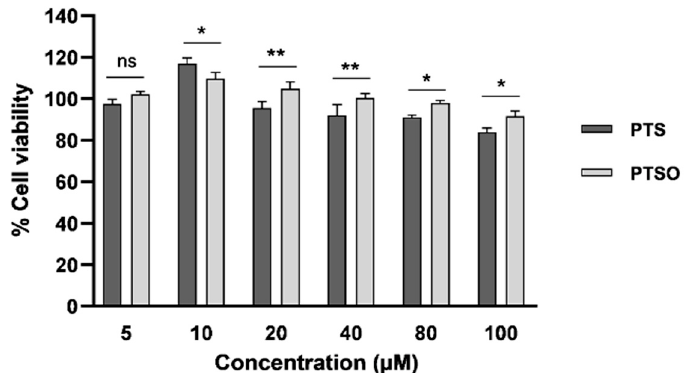
Figure 2. Effects of increasing concentrations of PTS and PTSO on hMSCs viability three days post-induction. The histogram depicts means ± SD of six determinations. * p < 0.05; ** p < 0.01; ns = non-significant.